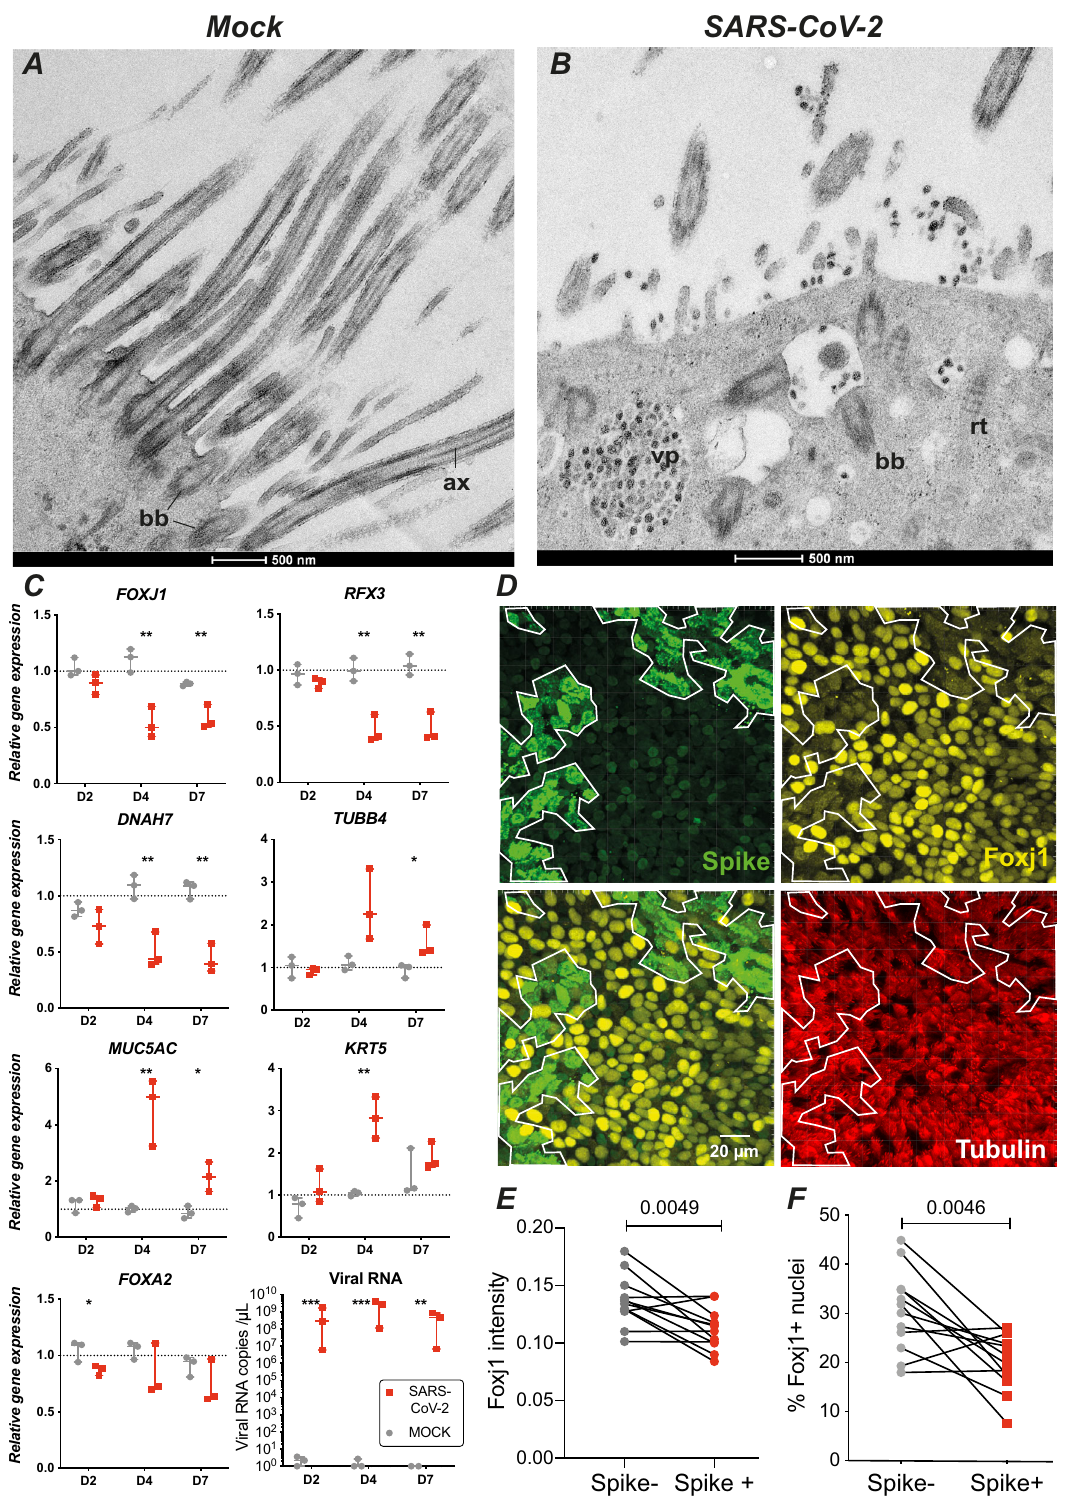
Fig. 4 SARS-CoV-2 infection perturbs ciliogenesis and induces Foxj1 downregulation. A TEM image of a mock-infected ciliated cell with elongated axonemes (ax) and membrane proximal basal bodies (bb). B TEM image of an infected ciliated cells at 4 dpi, with viral particle (vp) accumulation, mislocalized basal bodies, and isolated rootlets (rt). lp large particle. C Quantitation of transcripts expressed in mock- and SARS-CoV-2-infected epithelia (median ± range). The expression of 8 genes was measured by qPCR in n = 3 biological replicates from different donors and compared by t -tests with false discovery rate (FDR) correction for multiple comparisons (* P < 0.05, ** P < 0.01, *** P < 0.001). D Immuno fl uorescence analysis of epithelia at 2 dpi, after labeling for the viral spike (green), Foxj1 (yellow), and β -tubulin IV (red). The limit of the Spike + area is reported on each panel (white line). E, F The Foxj1 mean fl uorescence intensity in 3D-segmented nuclei ( E ) and the percentage of Foxj1 + nuclei ( F ) were compared in Spike − and Spike + areas for n = 4 donors with 3 replicates per donor, using a paired t